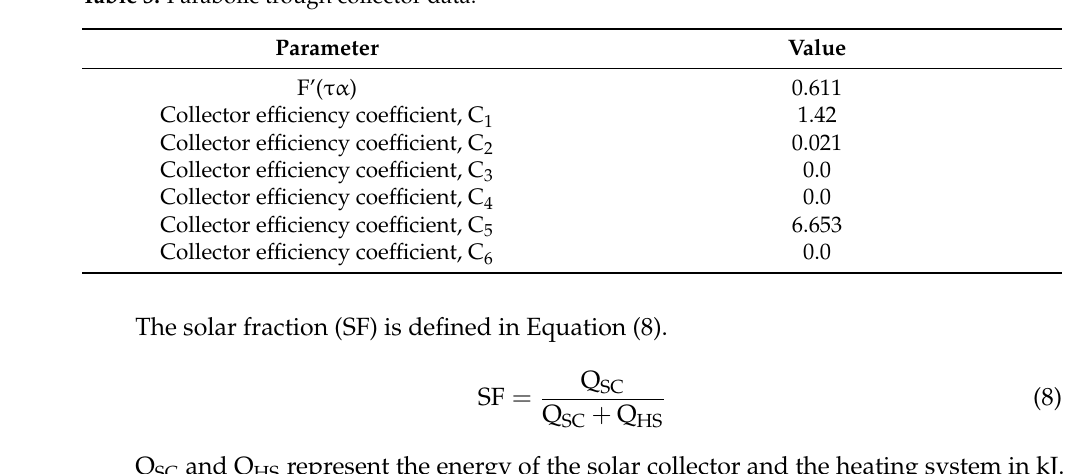
Table 3. Parabolic trough collector data.